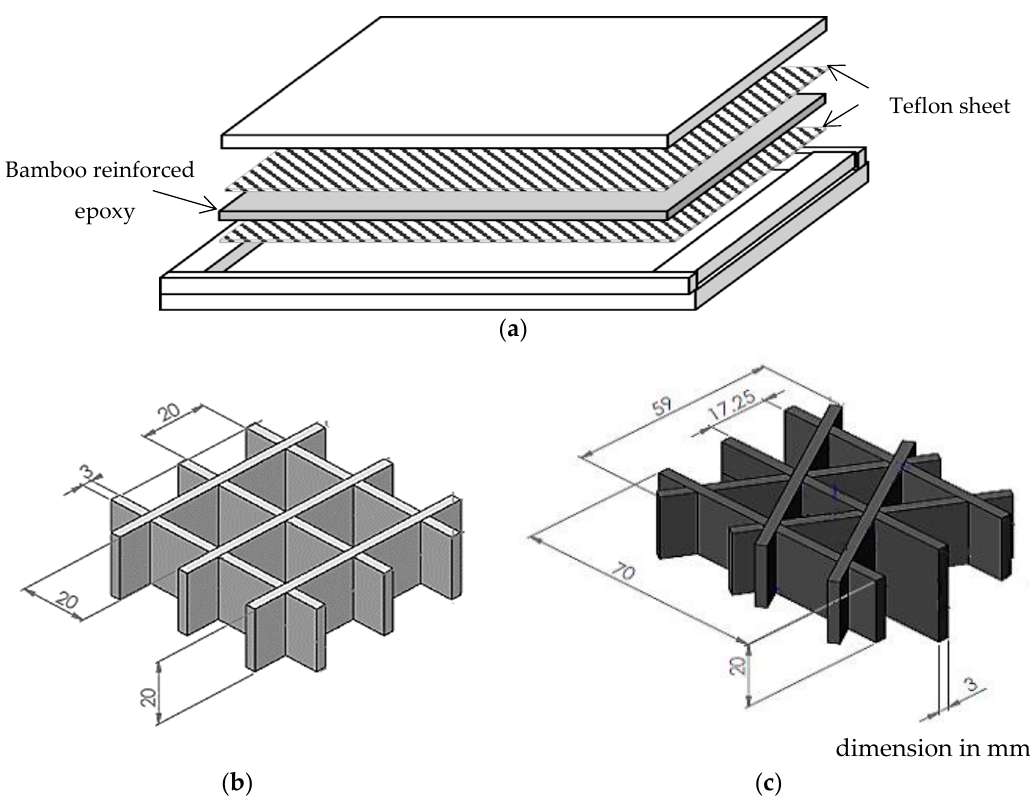
Figure 3. Schematic of ( a ) the bamboo-reinforced epoxy panel, with the ( b ) the square and ( c ) the triangular core structures.